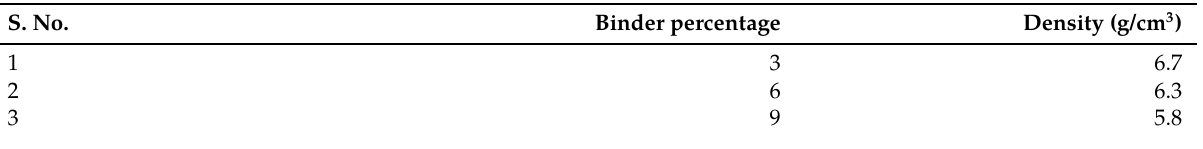
Table 2: Variation of density with the binder percentage. S.